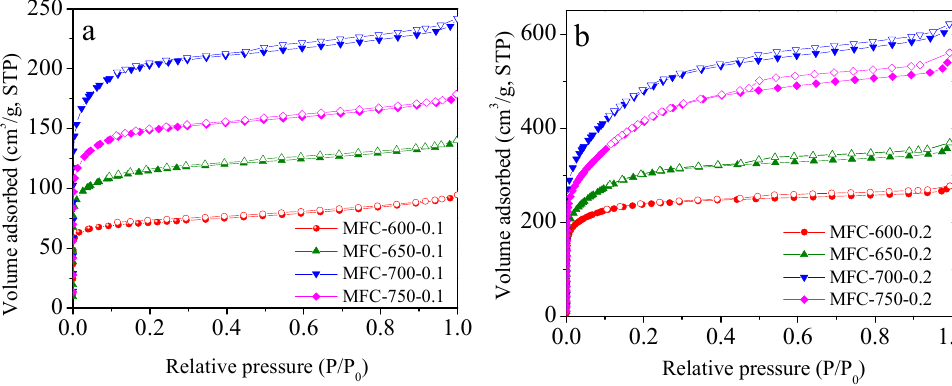
Figure 3. N 2 sorption isotherms of the samples prepared at KOH/MF ratio of ( a ) 0.1 and ( b ) 0.2. Filled and empty symbols represent adsorption and desorption branches, respectively. STP: standard temperature and pressure.